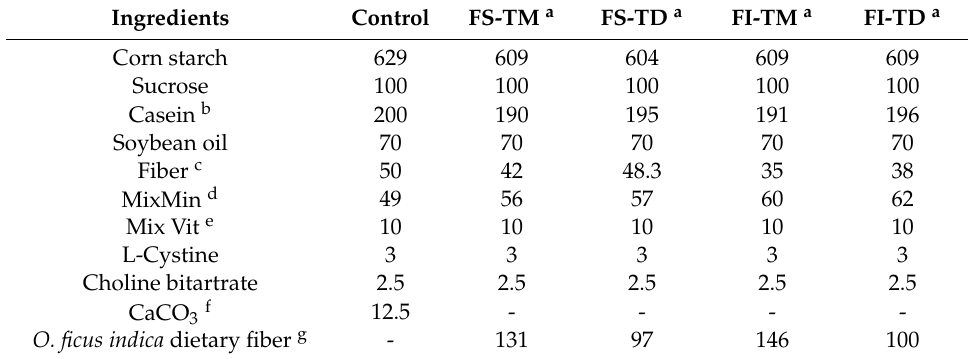
Table 1. Ingredient composition of the experimental diets containing soluble and insoluble dietary fiber extracted from Opuntia ficus indica cladodes as the only source of calcium (g / kg